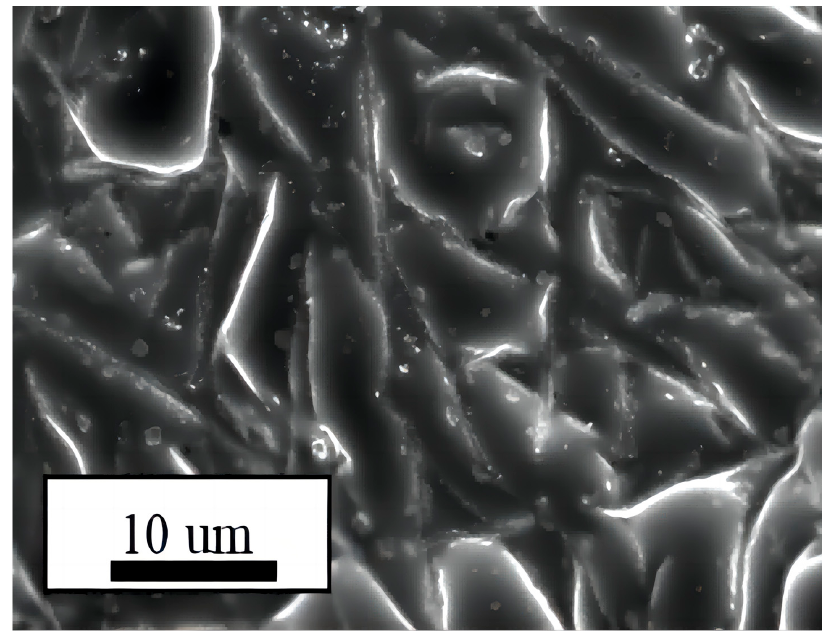
Figure 4. SEM image of the cured comb ‐ like PCL ‐ based GE membrane.